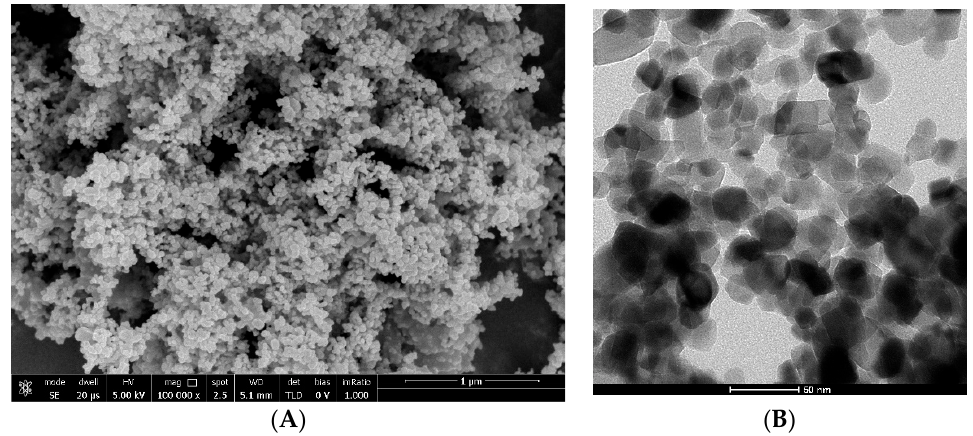
Figure 2. SEM ( A ) and TEM ( B ) images of the commercial Aeroxide P-25 photo-catalyst. The XRD pattern confirmed that the sample consisted of TiO 2 (Figure 3). Several peaks were detected: peaks (1 1 0), (1 0 1), (1 1 1), and (2 1 1) can be attributed to the rutile crystalline phase (R); peaks (1 0 1), (0 0 4), and (2 0 0) can be attributed to the anatase phase (A) [45]. The average crystallite grain size was calculated using the Scherrer equation, obtaining 28 nm and 23 nm for rutile and anatase phases, respectively. Values were calculated from the diffraction peaks at 2 θ = 54.1 ◦ and 25.3 ◦ , confirming the values estimated from TEM